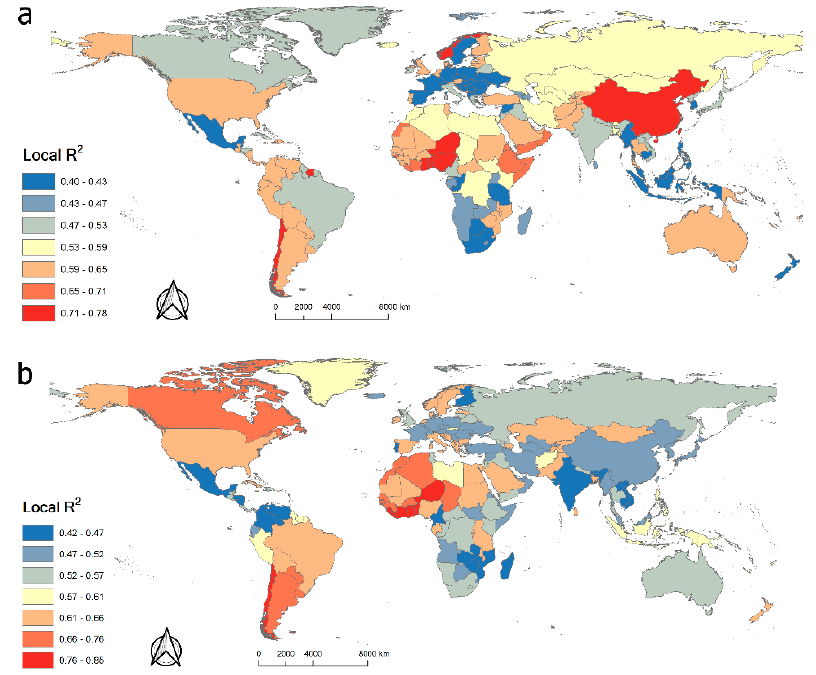
Figure 2. Geographic distribution of local R 2 for COVID-19: ( a ) confirmed cases and ( b ) deaths. The spatial distribution of estimated influence of population density and PM 2.5